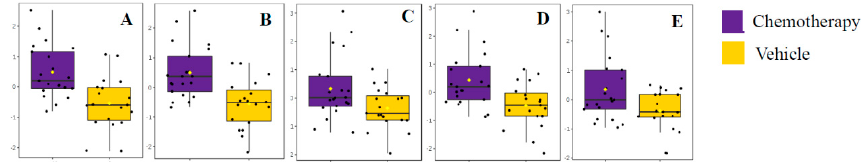
Figure 3. Box-plots demonstrating the median (central bar), 25% and 75% of metabolite intensities of the compounds impacted by chemotherapy, with n ≈ 20 per treatment group. ( A ) nervonic acid, ( B ) 13( Z )-docosenoic acid, ( C ) eicosatrienoic acid isomer, ( D ) 11( Z )-eicosenoic acid, ( E )-linoleic acid.